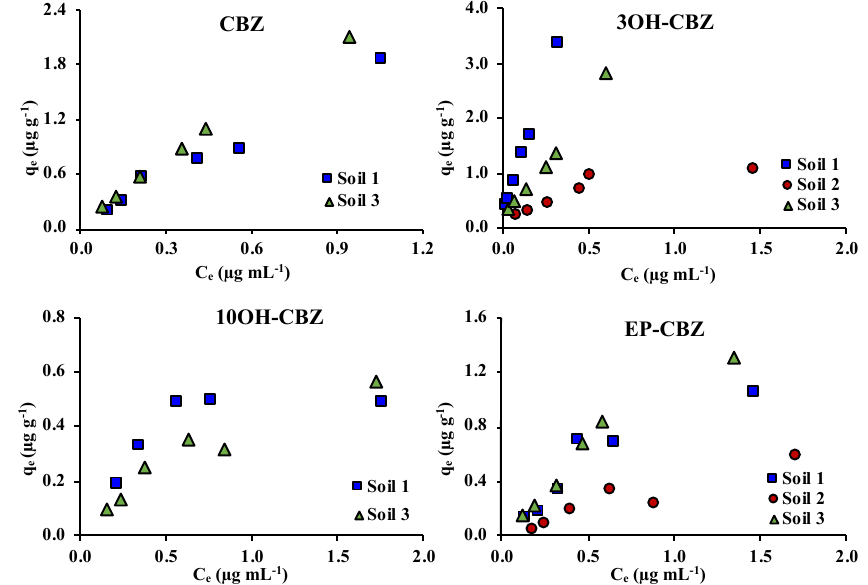
Figure 2. Adsorption curves for CBZ and its metabolites in studied soils in the single-solute systems; q e : amount of compound adsorbed; C e : concentration of compound in the equilibrium solution.